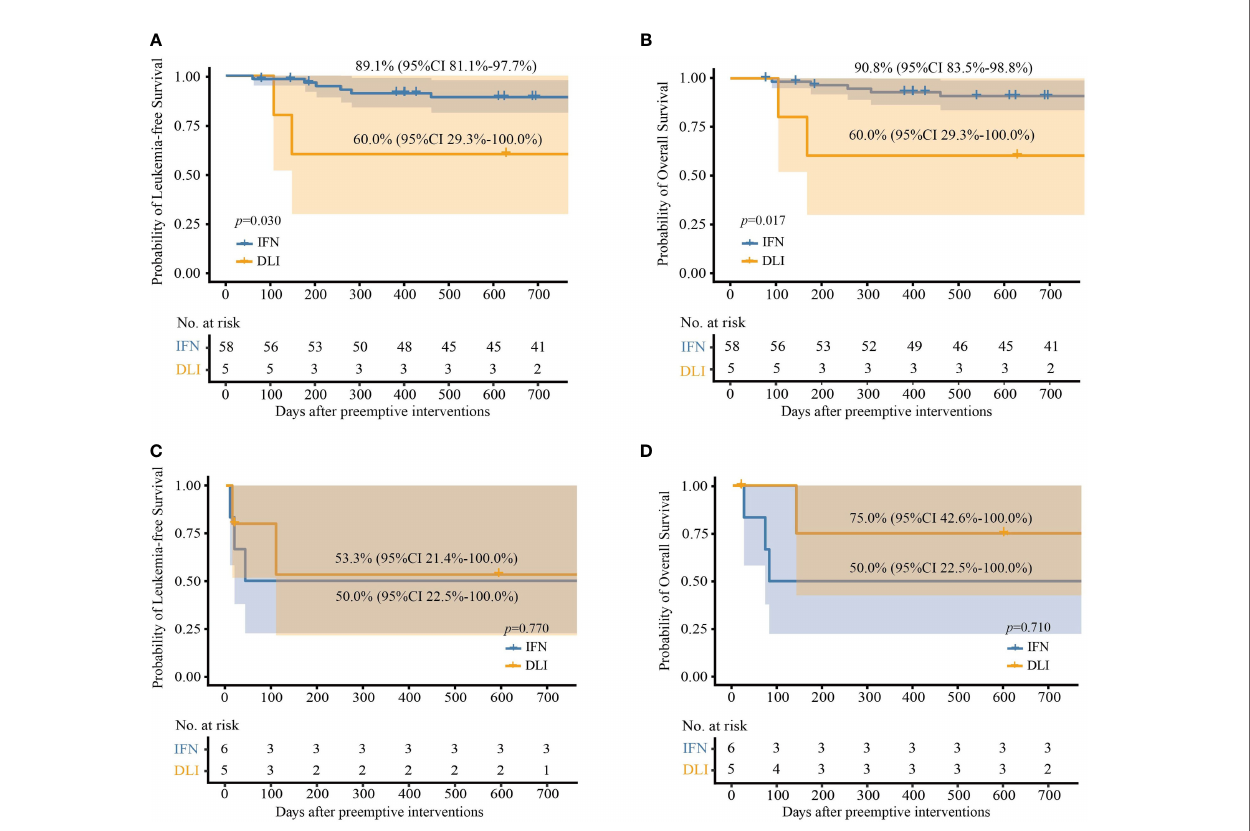
FIGURE 4 | Probabilities of survival at 2 years after preemptive immunotherapies in per protocol set. (A) Leukemia-free survival in patients with low- and intermediate-level RUNX1-RUNX1T1 ; (B) overall survival in patients with low- and intermediate-level RUNX1-RUNX1T1 ; (C) leukemia-free survival in patients with high-level RUNX1-RUNX1T1 ; (D) overall survival in patients with high-level RUNX1-RUNX1T1